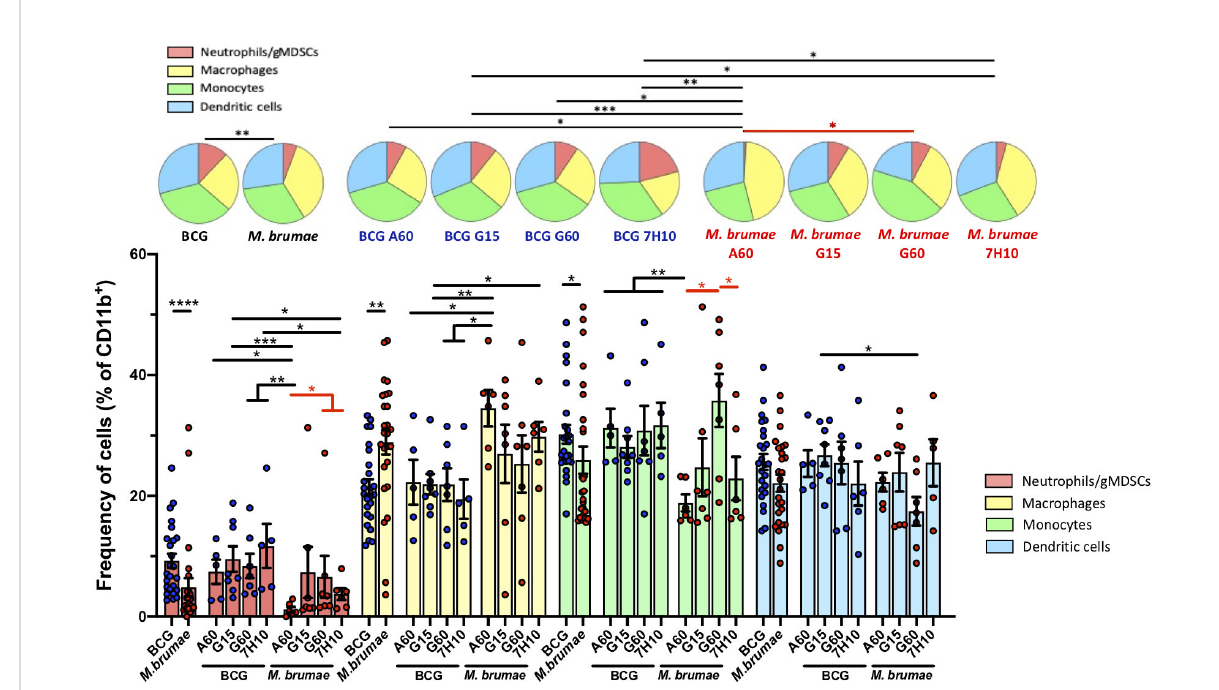
FIGURE 6 Changes in the tumor myeloid compartment after mycobacteria intravesical treatment. Pie chart representing proportional subpopulations of myeloid cells. CD3 - CD11b + tumor in fi ltrating myeloid cells were gated and the relative proportion of neutrophils, macrophages, monocytes and dendritic cells were represented and analyzed using SPICE software. Statistical analyses of the global maturation pro fi les were performed by partial permutation tests. Bar graphs indicate percentages of the different populations within the total CD11b + cells. Data represent the mean (bars) and ± SEM (error bars) and each dot represent an individual mouse treated with BCG (blue dots) or M. brumae (red dots). Statistically signi fi cant differences between the different M. brumae mycobacteria are shown as red lines. Interstrain differences are shown in black. Differences were tested using Mann-Whitney U nonparametric test. *p ≤ 0.05; **p ≤ 0.01; ***p ≤ 0.001; ****p ≤ 0.0001. Neutrophils (red; CD11b + CD11c - Ly6G + ), macrophages (yellow, CD11b + CD11c - F4/80 hi ), monocytes (green, CD11b + CD11c - F4/80 lo/int ) and dendritic cells (blue, CD11b + CD11c +